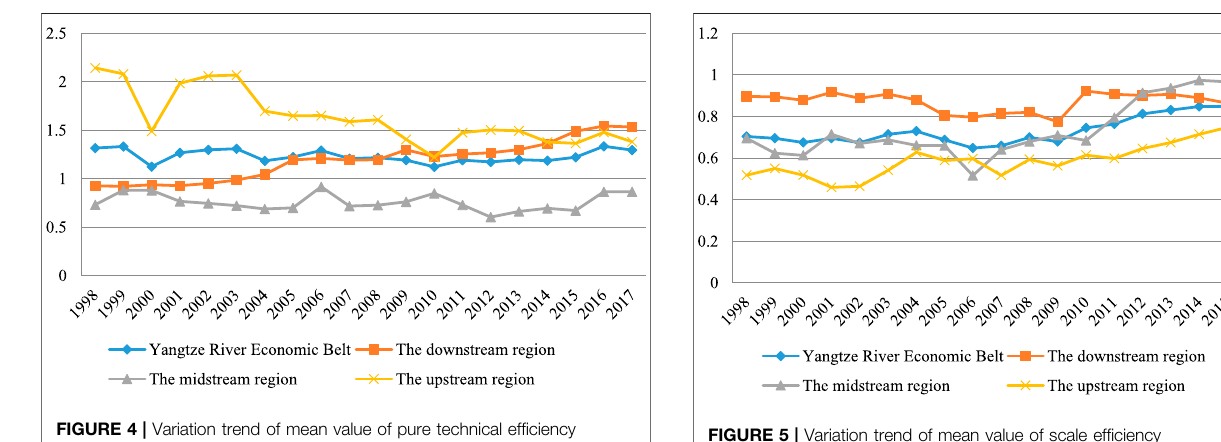
FIGURE 5 | Variation trend of mean value of scale ef fi ciency (1998 –